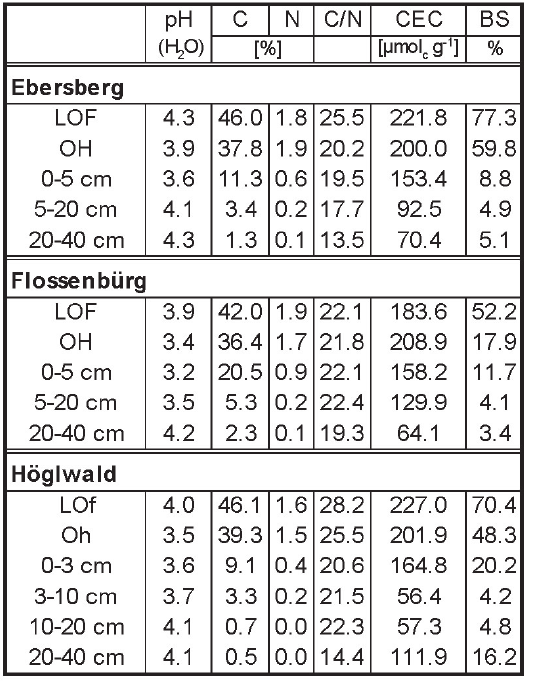
TABLE 2 Soil Characteristics of the Three Experi- mentation Sites: Ebersberg, Flossenbürg, and